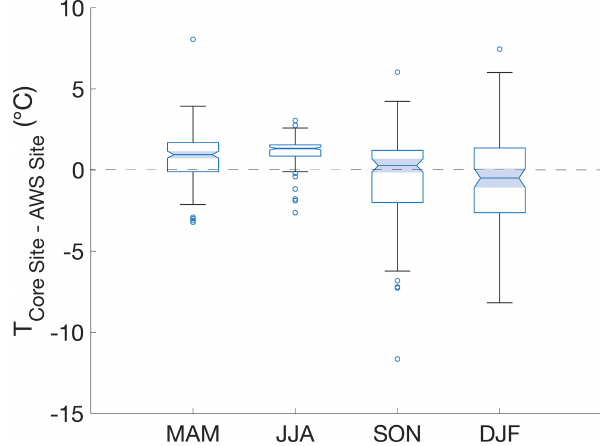
Figure 4. Differences between MODIS LSTs at the Divide ice core and AWS sites. Shaded notched areas indicate the 95% confidence interval for the median temperature difference. Horizontal dashed line indicates where MODIS LSTs at the ice core site and AWS site are equivalent.